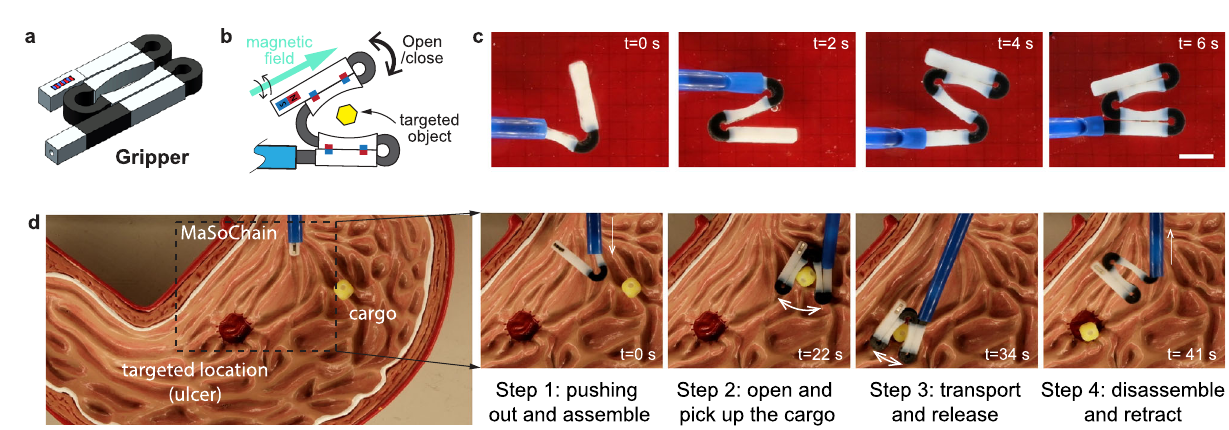
Fig. 5 | Large magnetic tweezers from self-folding MaSoChain. a , b The design and structure diagram ofa large magnetic tweezer using a self-folding MaSoChain. c The folding process of the magnetic tweezer. The complete folding process can be seen in Supplementary Movie 4. The scale bar is 1cm. d Demonstration of